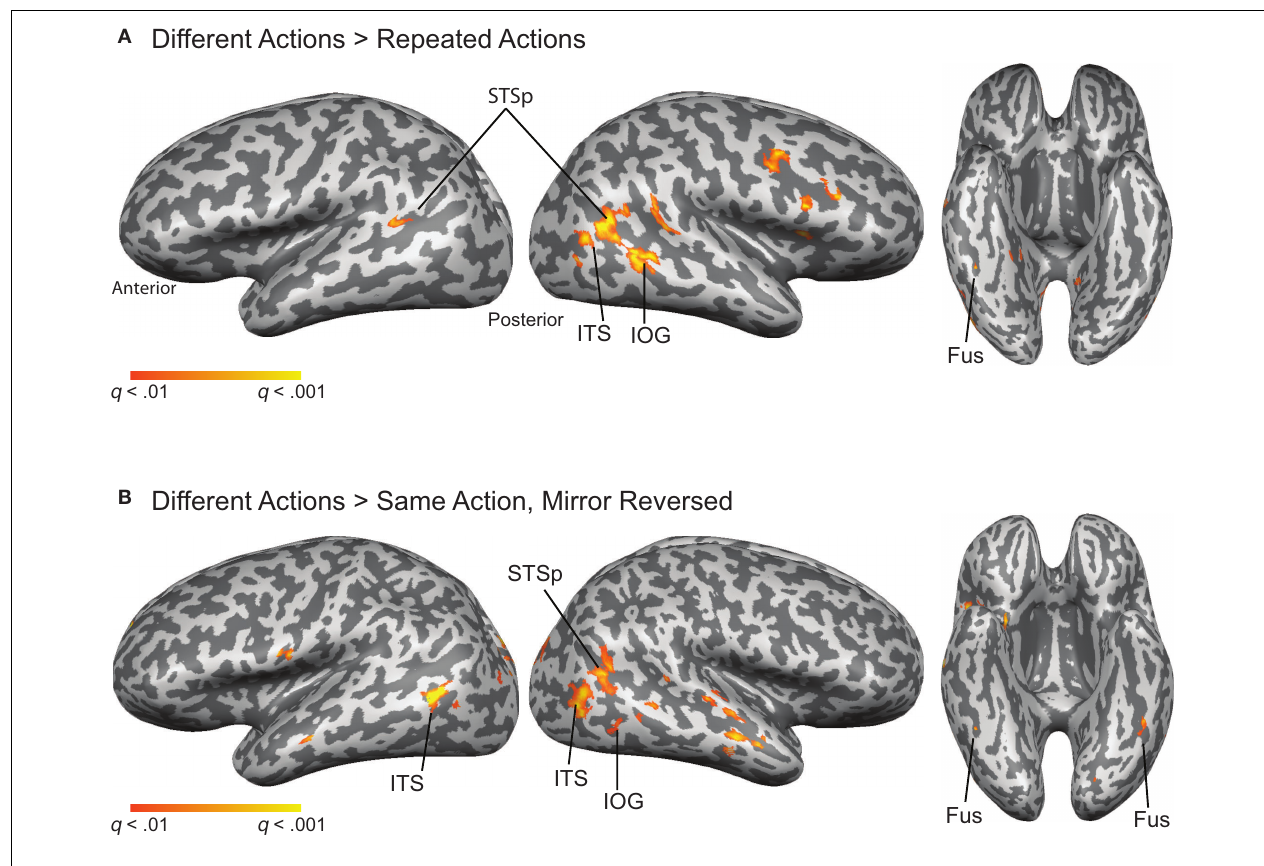
FIGURE 7 | Group GLM results for statistical contrasts testing for fMR- adaptation in the deconvolved BOLD response, overlaid on a single subject anatomy. (A) Group contrast testing for adaptation for the repeated action trials